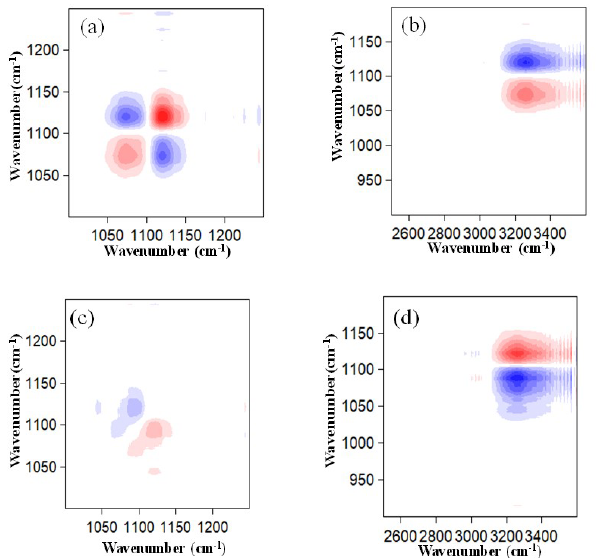
Figure 7. Panels (a) and (b) are synchronous correlation maps of AS nanoparticles within different wavenumber regions. Panels (c) and (d) are the same as (a) and (b) but for asynchronous correlation maps. Red and blue areas represent positive and negative correla- tions,